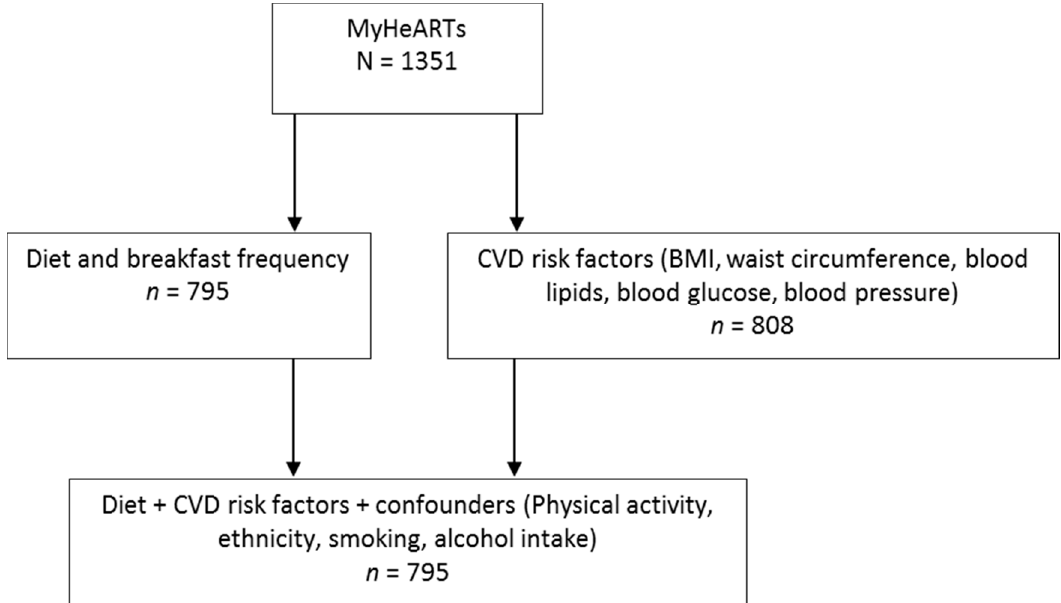
Figure 2. Number of participants with data available based on the variables of interest. CVD: cardiovascular disease; MyHeARTs: Malaysian Health and Adolescents Longitudinal Research Team study.